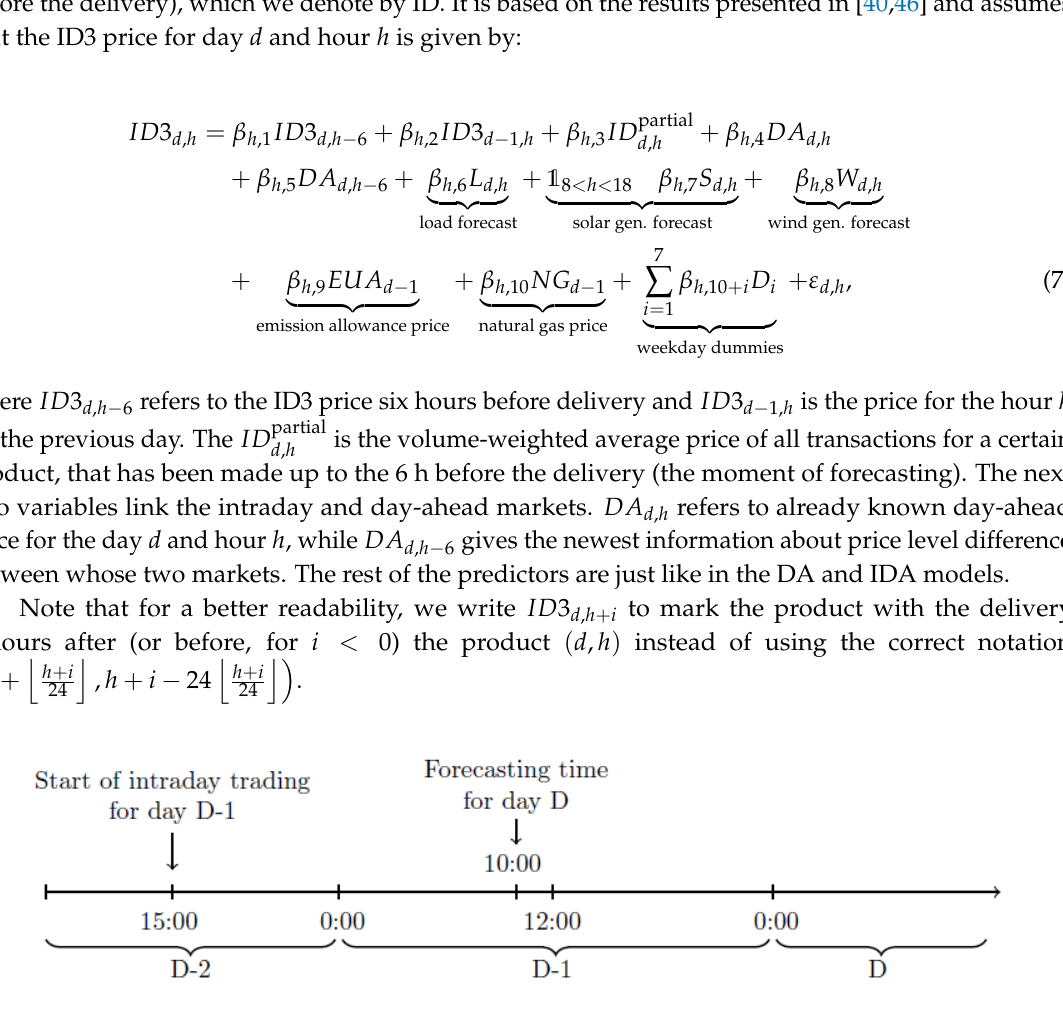
Figure 4. Market trading timeline; the forecasting of DA and IDA for day D is performed at 10:00 of day D −